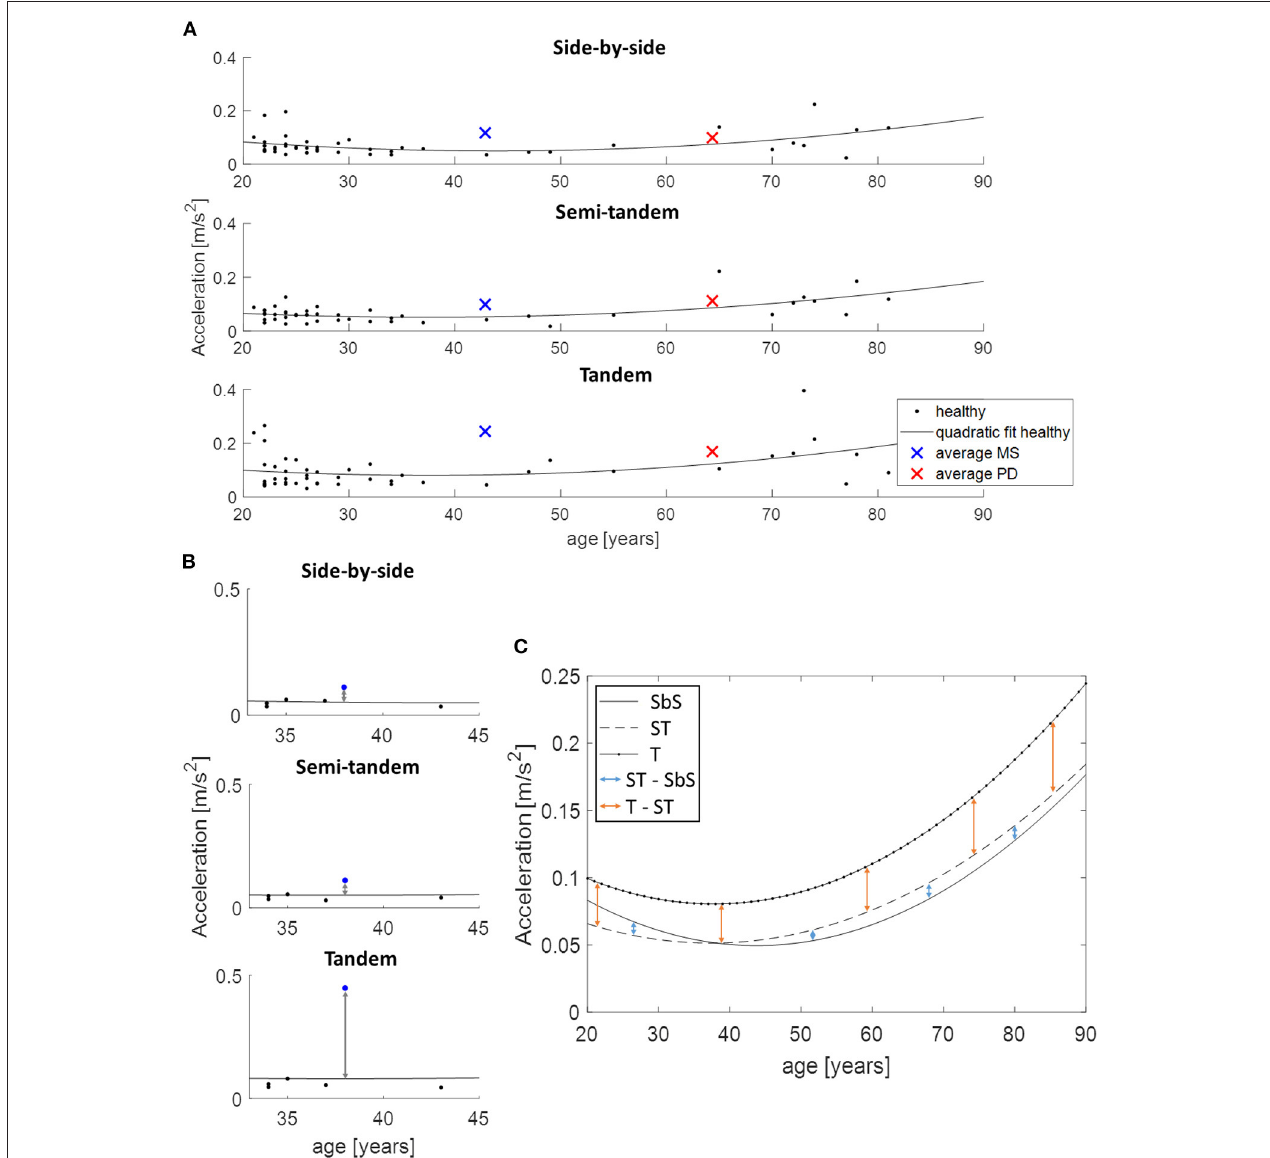
FIGURE 2 | Use of the quadratic function to allow age-corrected comparisons between disease groups, demonstrated on acceleration in medio-lateral direction. (A) An example of the quadratic fit based on the data of all healthy adults and the average values of the multiple sclerosis (MS, blue cross) and Parkinson’s disease (PD, red cross) patients. (B) The distance between the performance of an MS patient (blue dot) and the estimated value of the age-matched healthy adults is presented. These distances are subtracted from each other to calculate the change between the tasks. (C) Shows the calculation of the changes between the tasks for the healthy adults, where the quadratic fits are subtracted from each other. SbS, side-by-side stance; ST, semi-tandem stance; T, tandem stance.